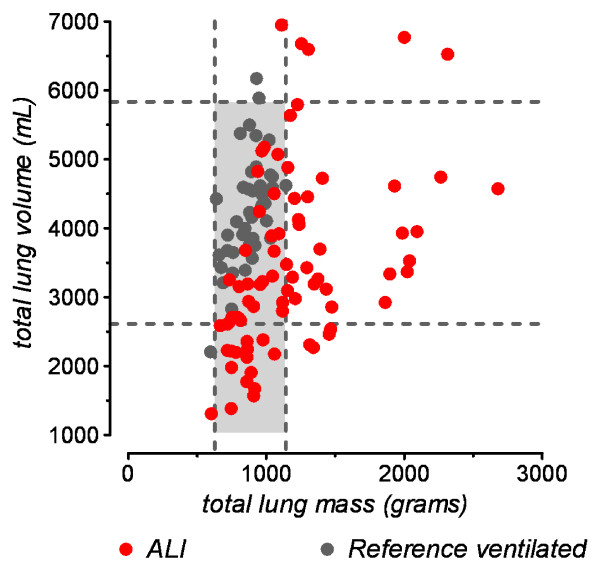
Comparison of lung weights. Lung weights of 78 patients with acute lung injury (ALI) upon admission (red circles) in comparison to the values of 43 mechanically ventilated trauma patients with morphologically and functionally normal lungs (reference ventilated, gray circles). Dashed lines mark the 95% reference intervals for total lung mass and total lung volume, respectively, calculated from reference ventilated patients. Because reference ventilated patients were ventilated with the same positive end-expiratory pressure (10 cmH2O) and also underwent computed tomography during uninterrupted mechanical ventilation, only these reference ventilated patients were used for the graphical comparison with ALI patients in this graph. ALI patients whose data points fall within the gray box did not have an increased lung weight.